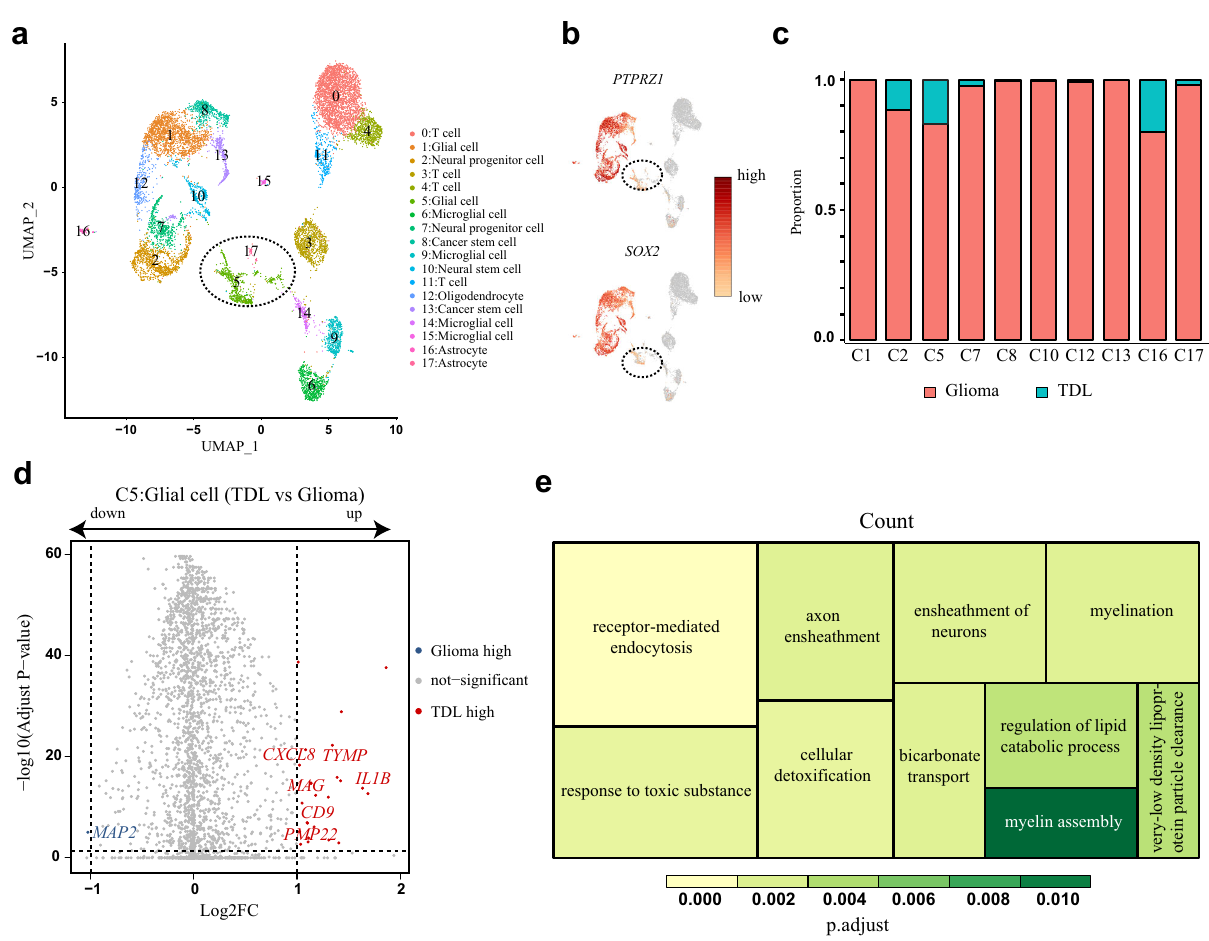
Fig. 3 Cell clusters of nonimmune cells and transcriptomic difference of glial cells between TDL and glioma. a , b UMAP plots with expression level of SOX2 and PTPRZ1 revealed the two benign clusters (C5, C17) derived from both glioma and TDL. c Proportion plot of nonimmune clusters deriving from TDL and glioma. d Volcano plot of differentially expressed genes (DEGs) that are upregulated (red) or downregulated (blue) in glial cells (C5) of TDL by comparing to glial cells (C5) of glioma. e Treemap of Gene Ontology (GO) enrichment analysis for biological process based on DEGs between C5 cells from TDL and glioma. TDL tumefactive demyelinating lesion, UMAP Uniform Manifold Approximation and Projection. DEGs differentially expressed genes, FC fold